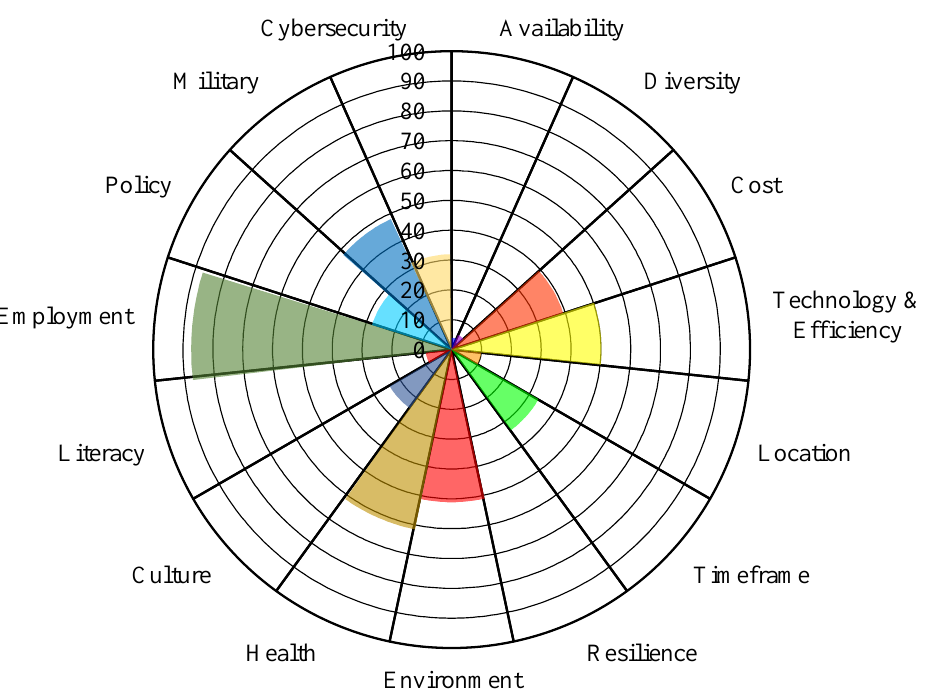
Figure 22. Detailed energy security view for Central African Republic, values 0–100 represent worst to best.